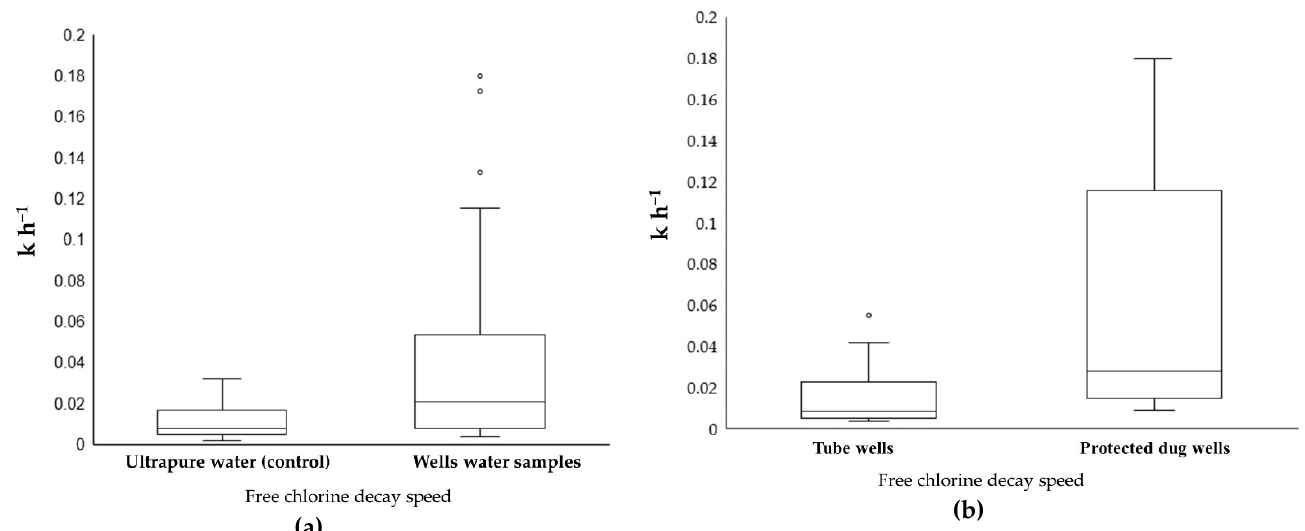
Figure 4. Box-and-whisker plots (min/max, lower/upper quartiles, and median) of free chlorine decay speed. ( a ) ultrapure water (control) and well water samples; ( b ) water samples from protected dug wells and tube wells.